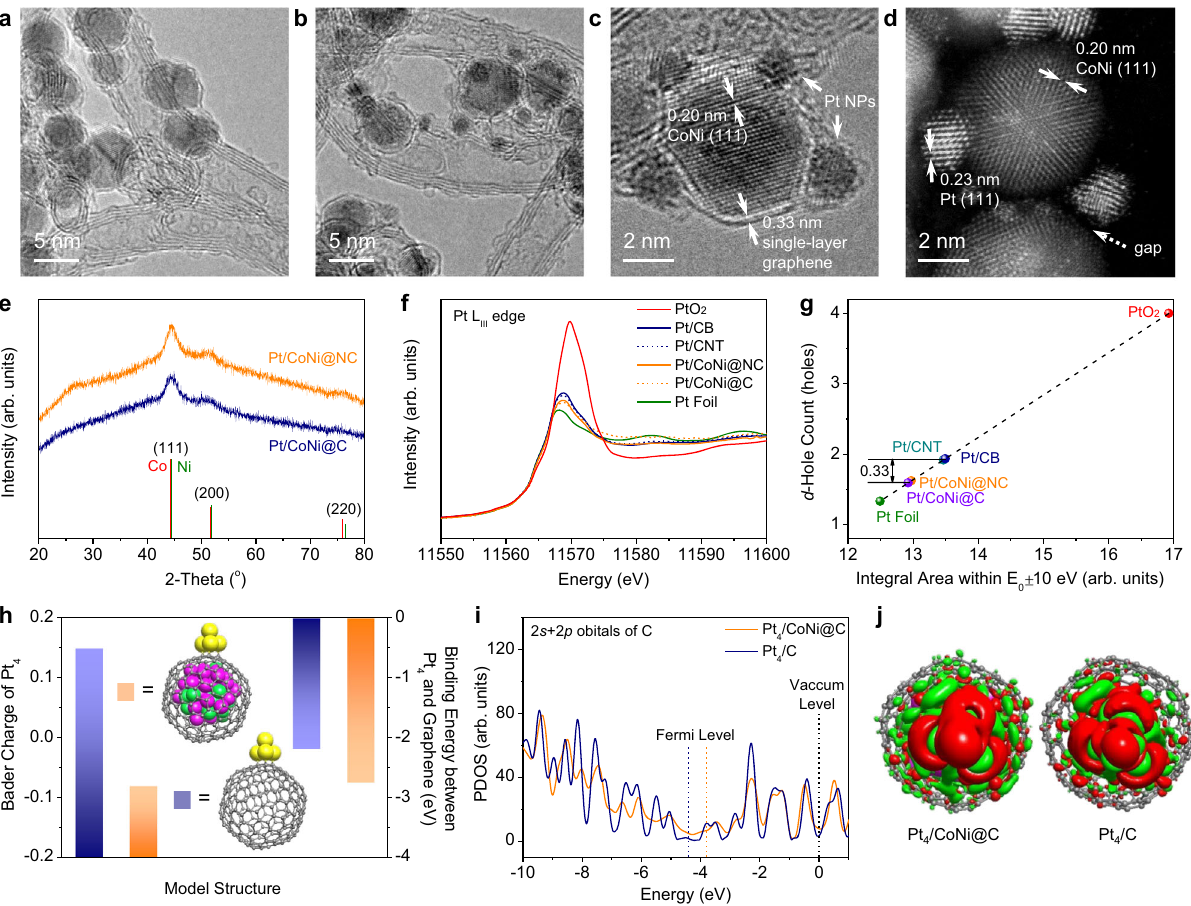
Fig. 1 Structural characterization and modeling of Pt on graphene encapsulating CoNi alloy. a TEM image of CoNi@NC. b , c TEM images of Pt/CoNi@NC. d HAADF-STEM image of Pt/CoNi@NC. e XRD patterns of Pt/CoNi@NC and Pt/CoNi@C. f XANES spectra of Pt L III edge for Pt/CoNi@NC, Pt/CoNi@C, Pt/ CNT, and Pt/CB. g d -hole count of Pt in each catalyst calculated from their XANES spectra. h Catalyst models of Pt 4 on graphene cages with and without CoNi NPs inside and the corresponding Barder charge of Pt 4 (columns on the left) and the binding energy between Pt 4 and graphene (columns on the right). i PDOS of 2 s + 2 p orbitals of C atoms in Pt 4 /CoNi@C and Pt 4 /C. j Top view of differential charge density of Pt 4 /CoNi@C and Pt 4 /C. The red and green regions indicate electron increment and depletion,